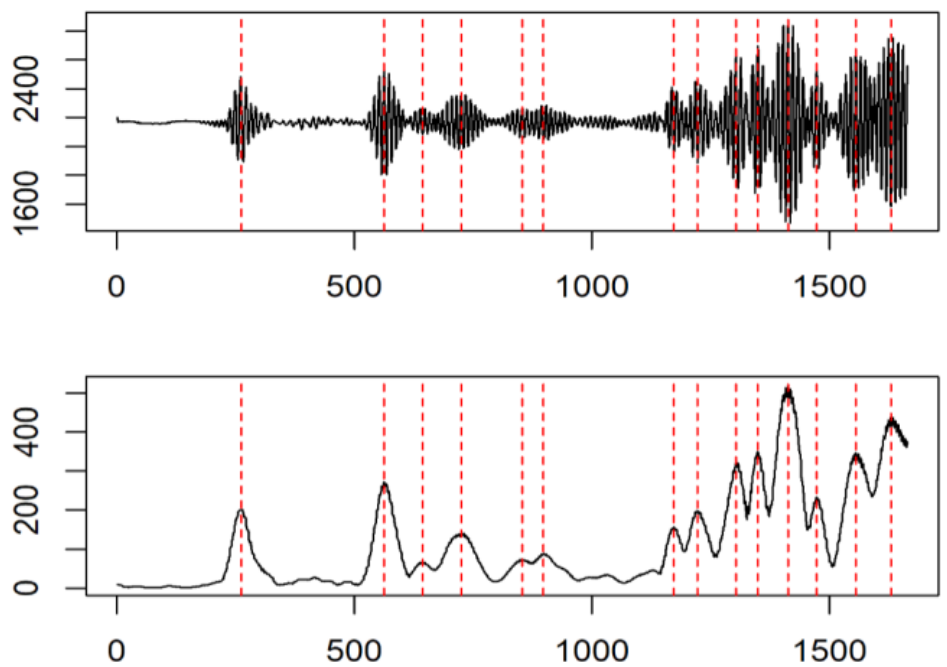
Figure 8. Comparison of the raw and the transformed signal (radius = 11). Red lines indicate local extremes.